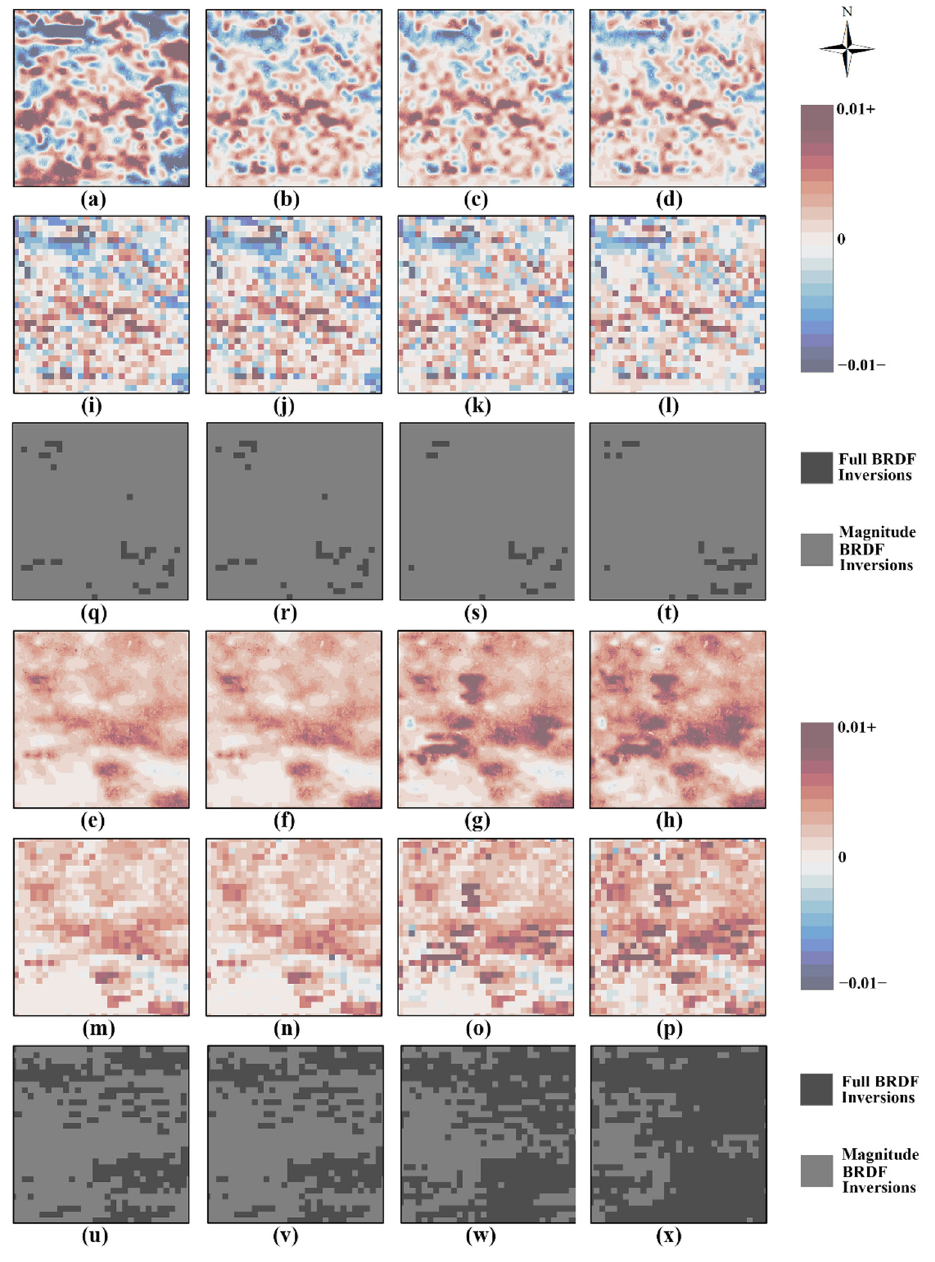
Figure 11. ( a – h ) depict the difference distributions of black-sky new albedo products from 9 April 2014 and that from adjacent dates (5th, 6th, 7th, 8th, 10th, 11th, 12th, and 13th of April 2014), respectively, in the 15 × 15 km range at Goodwin Creek (GWN). ( i – p ) show the corresponding difference distributions in MODIS black-sky albedo. Red depicts areas with higher albedo than 9 April 2014, and blue shows the opposite. ( q – x ) depict the corresponding quality marks of MODIS